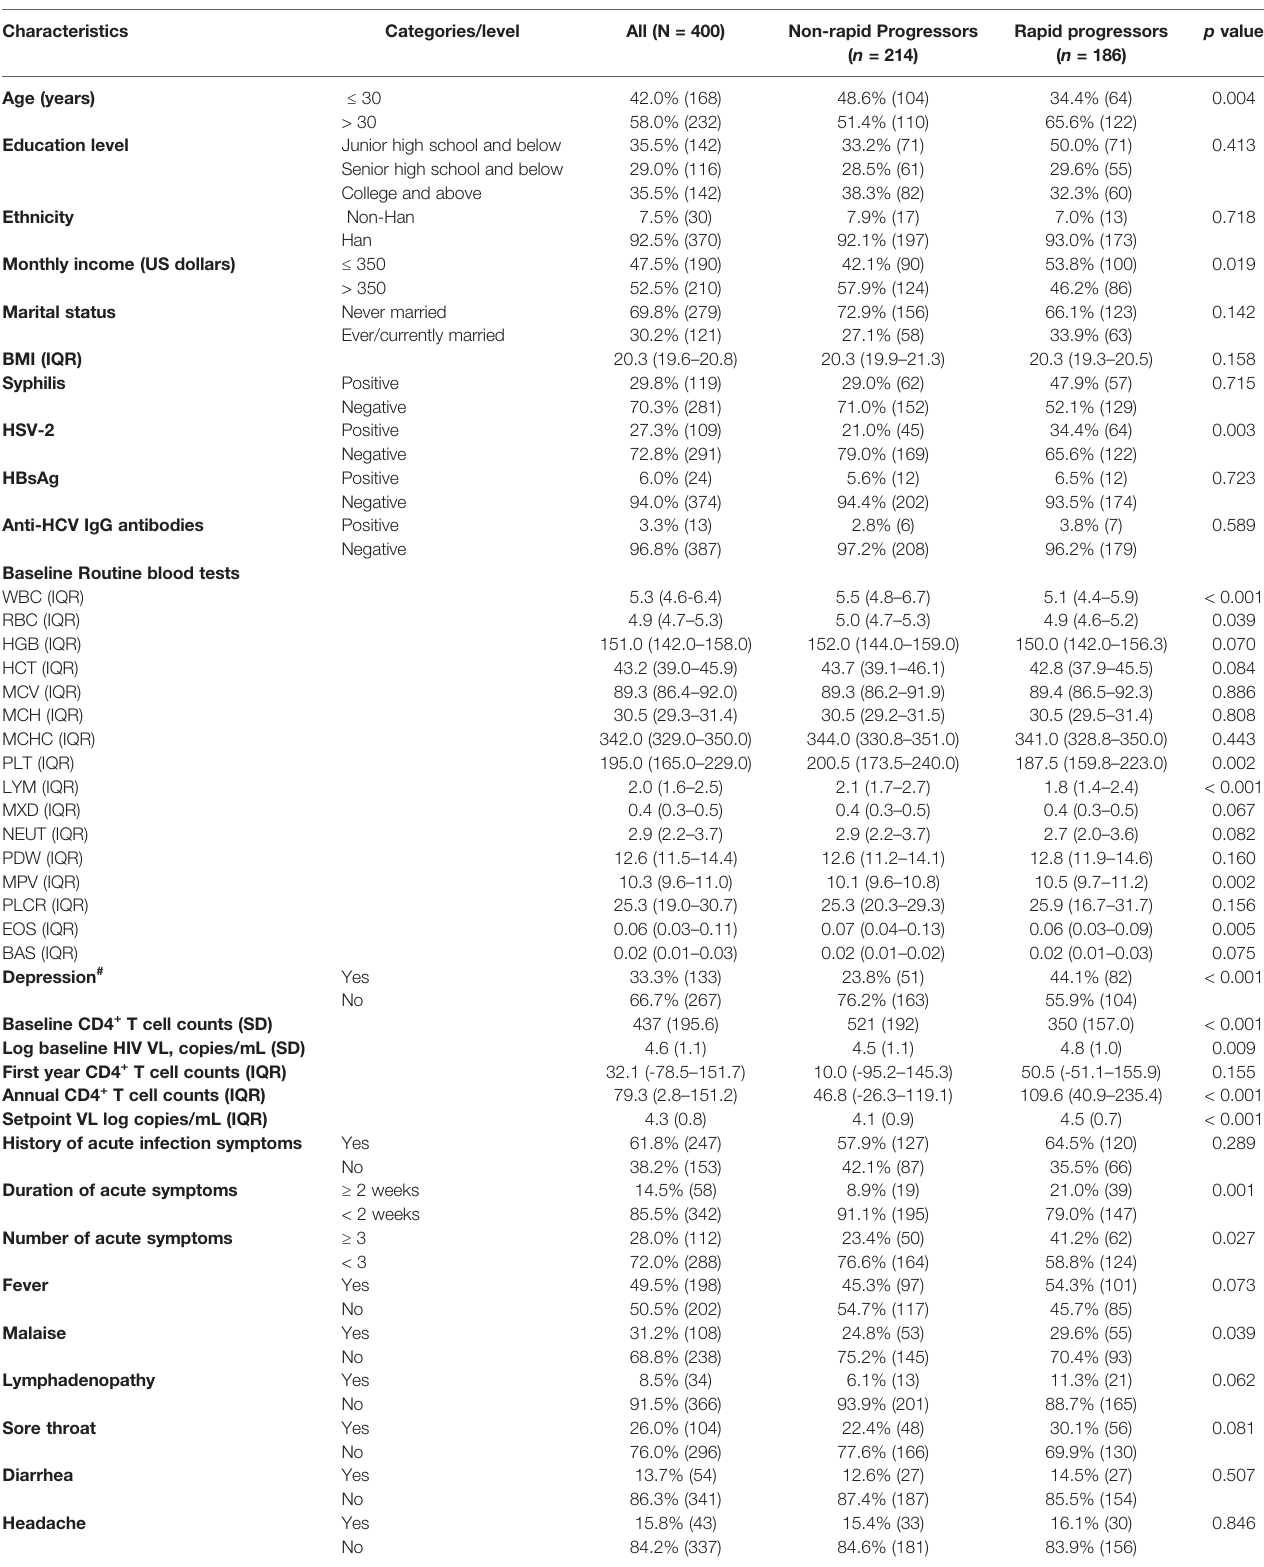
TABLE 1 | Demographics, behaviors, and acute symptoms in a cohort of patients with AHI (N = 400).